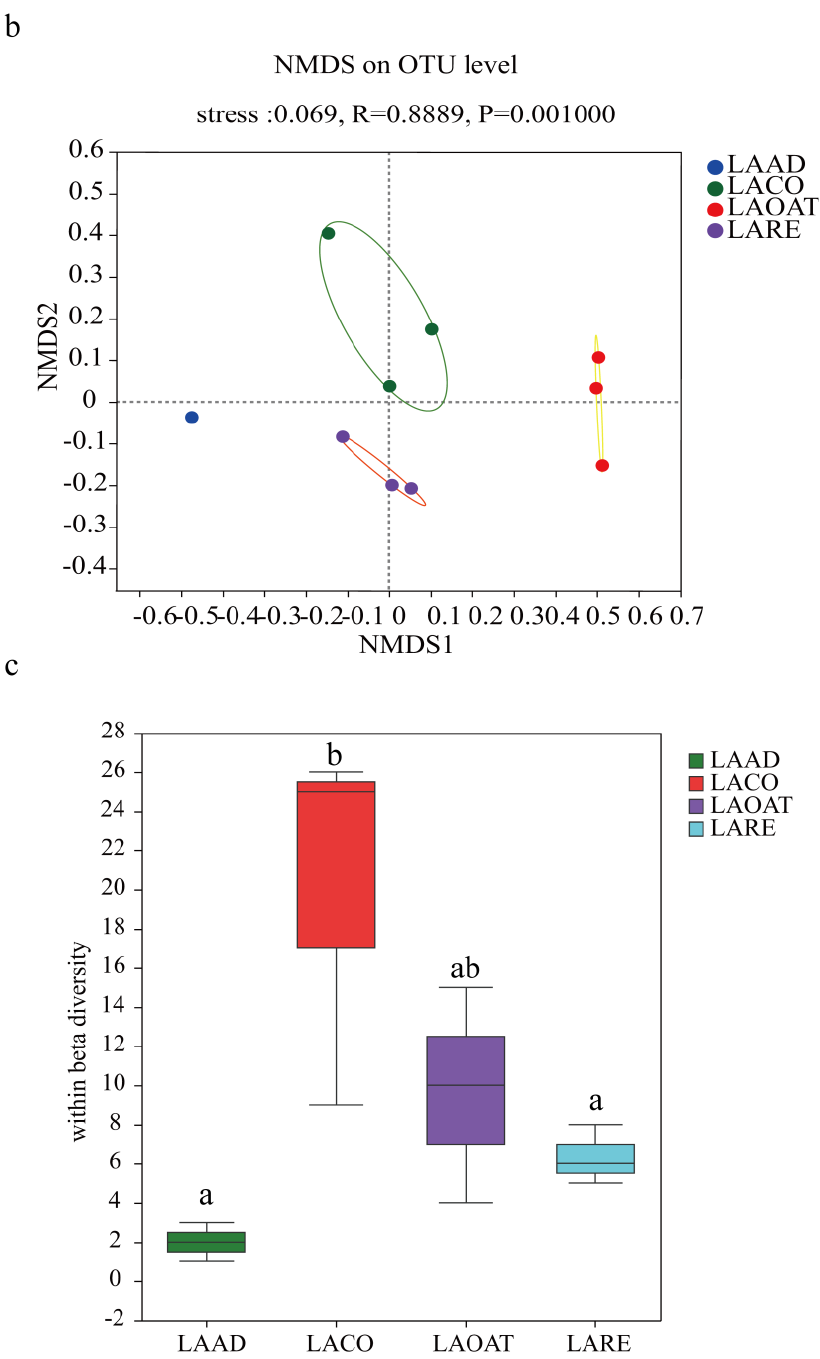
Figure 2. Beta diversity and within beta diversity analyses of C. suppressalis larvae on different diets. ( a ) PCoA (principal coordinates analysis) based on the Bray − Curtis distance at OTU level. ( b ) NMDS (non-metric multidimensional scaling) diagrams based on the Bray − Curtis matrix at OTU level. ( c ) At each diet, variations of within beta diversity (sample dispersion) were measured as the distance of each sample from the centroid of each diet group. Distance was calculated using the OTU level of each sample group based on Bray − Curtis. The distribution of within beta diversity for each diet was visualized using boxplots (reported data: minimum, first quartile, median, third quartile, and maximum). LAAD: larvae fed on an artificial diet, LACO: larvae fed on a corn diet, LARE: larvae fed on a rice diet, and LAOAT: larvae fed on a water oat diet. Different letters indicate significant differences across the treatments, p <